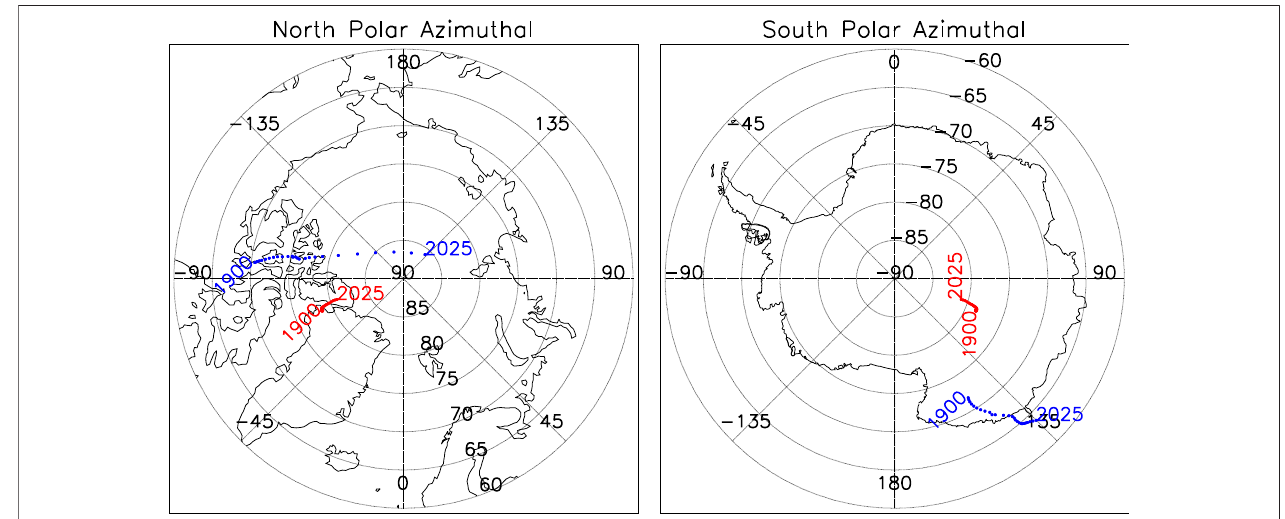
FIGURE 2 | Center location of the IGRF magnetic fi eld for different years from 1900 to 2025 with the time resolution of 5 years. The blue dots are the magnetic dip pole centers, and the red ones are the geomagnetic pole centers. The data are from the article by Alken et al. (2020).